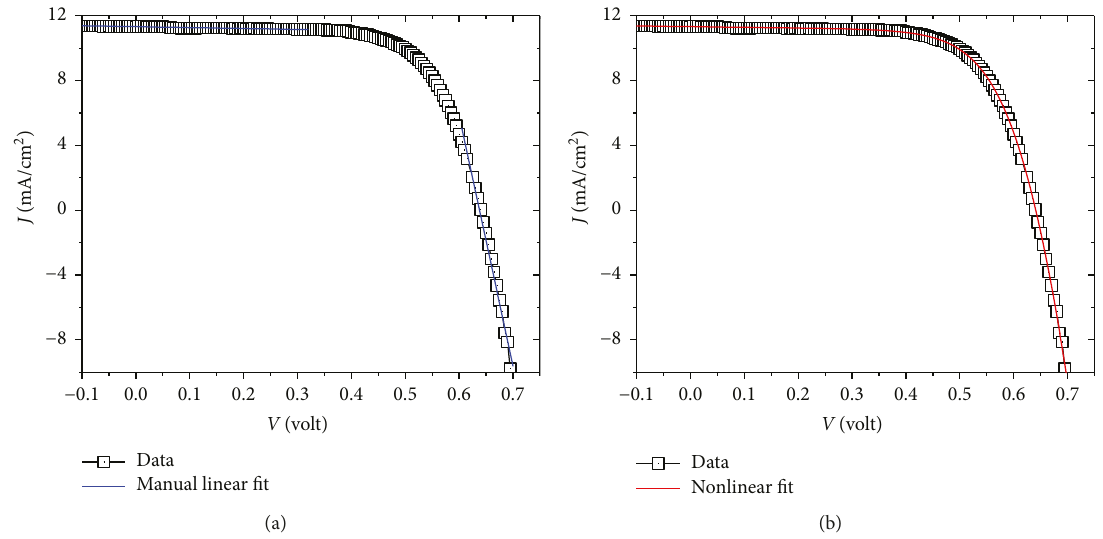
Figure 6: Organic solar cell based on p-type NiO: (a) manual method and (b) nonlinear curve fi t.